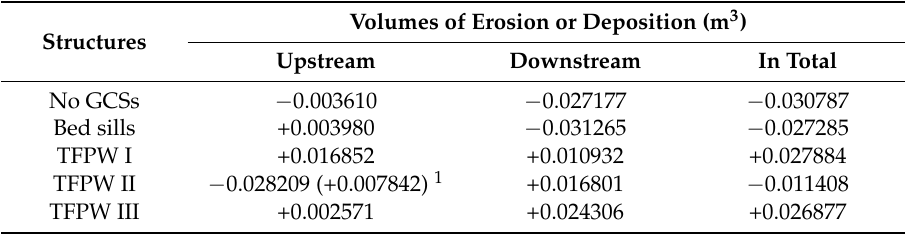
Table 2. Results of volumes for erosion or deposition in the test reach under different structural conditions.